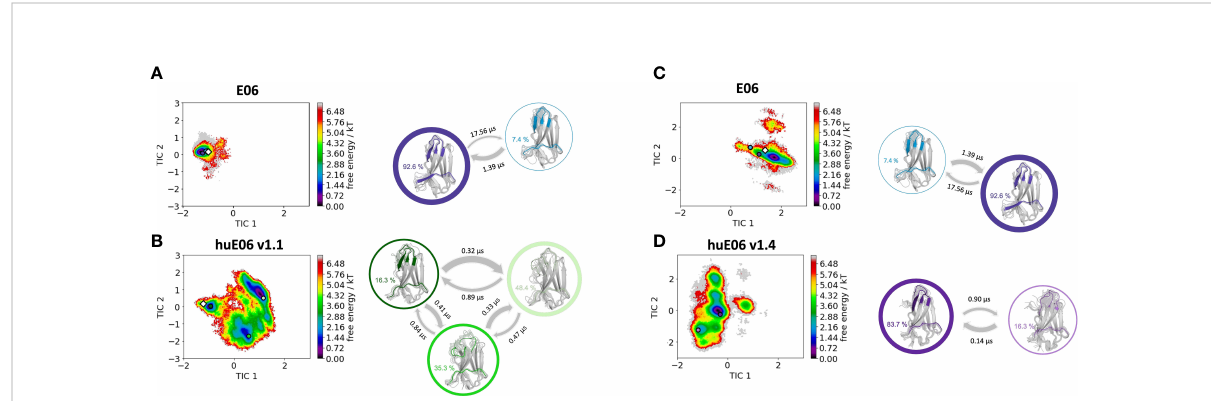
FIGURE 4 Kinetic and thermodynamic VNAR binding site ensemble characterization of the parent E06 VNAR and the humanized variants huE06 v1.1 and huE06 v1.4. (A, B) Free energy landscapes with the respective state probabilities, transition timescales and macrostate representatives of the parent E06 and the humanized variant huE06 v1.1 in the same coordinate system. The crystal structures are depicted as white diamonds. Macrostate representatives are projected into the free energy landscape as dots, color-coded according to the structures on the right. The thickness of the arrows denotes the transition timescale and the width of the surrounding circle represents the state population. (C, D) Free energy surfaces with the respective state probabilities, transition timescales and macrostate representatives of the parent E06 and the humanized variant huE06 v1.4 in the same coordinate system. The available crystal structure is depicted as white diamond.